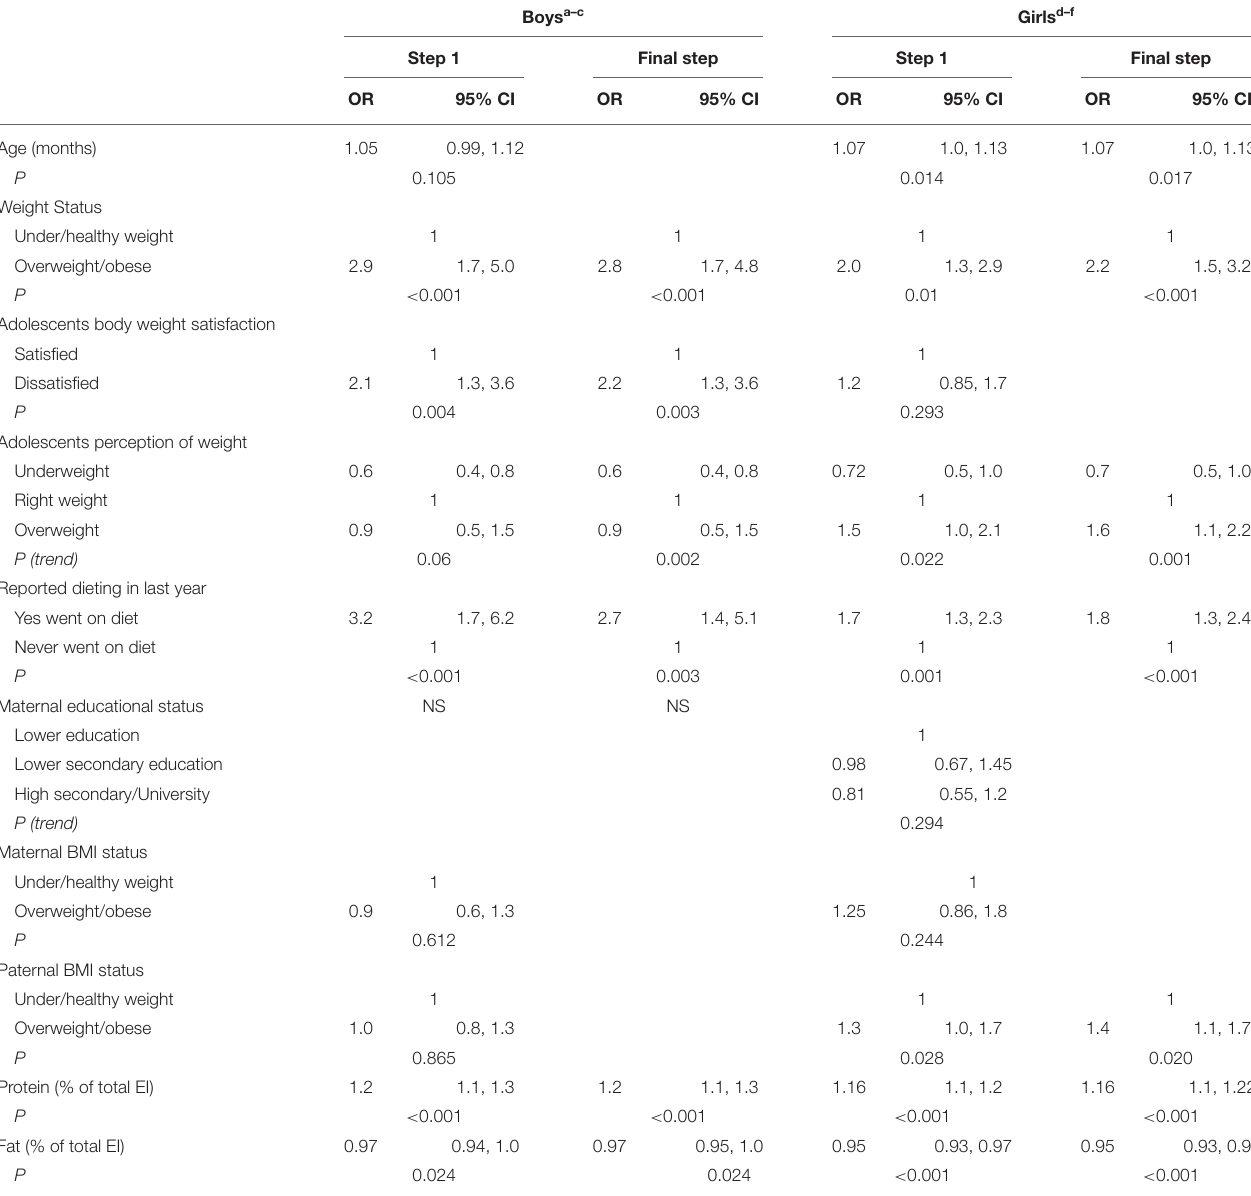
TABLE 3 | Binary logistic regression: associations of age, weight status, body image, dieting, and sociodemographic variables with underreporting of dietary energy intake (odds ratio and 95% confidence intervals) in 13-year-old